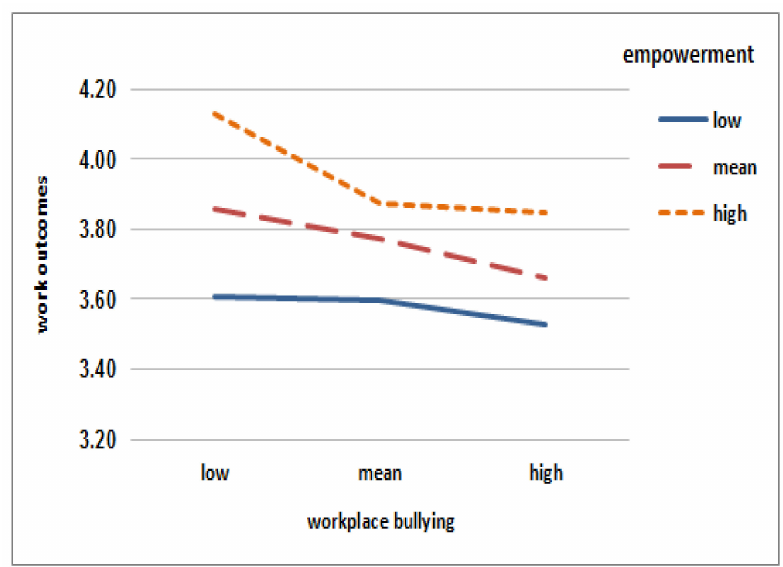
Figure 2. Simple slopes equations for the association between workplace bullying and nursing work outcomes by structural